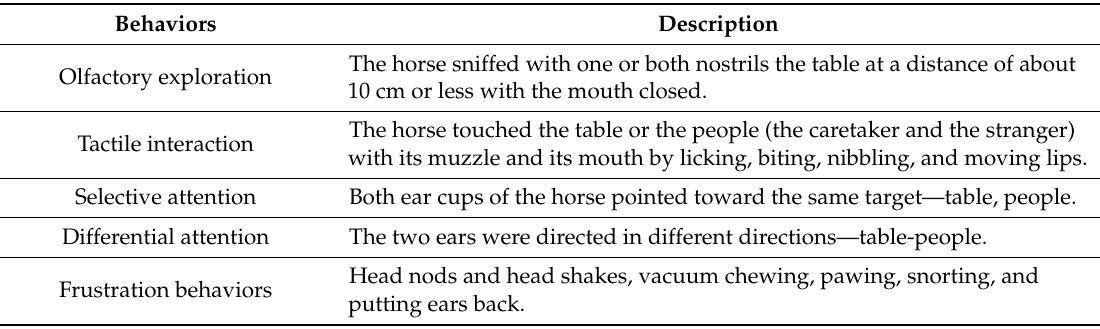
Table 1. Behaviors recorded during the test with